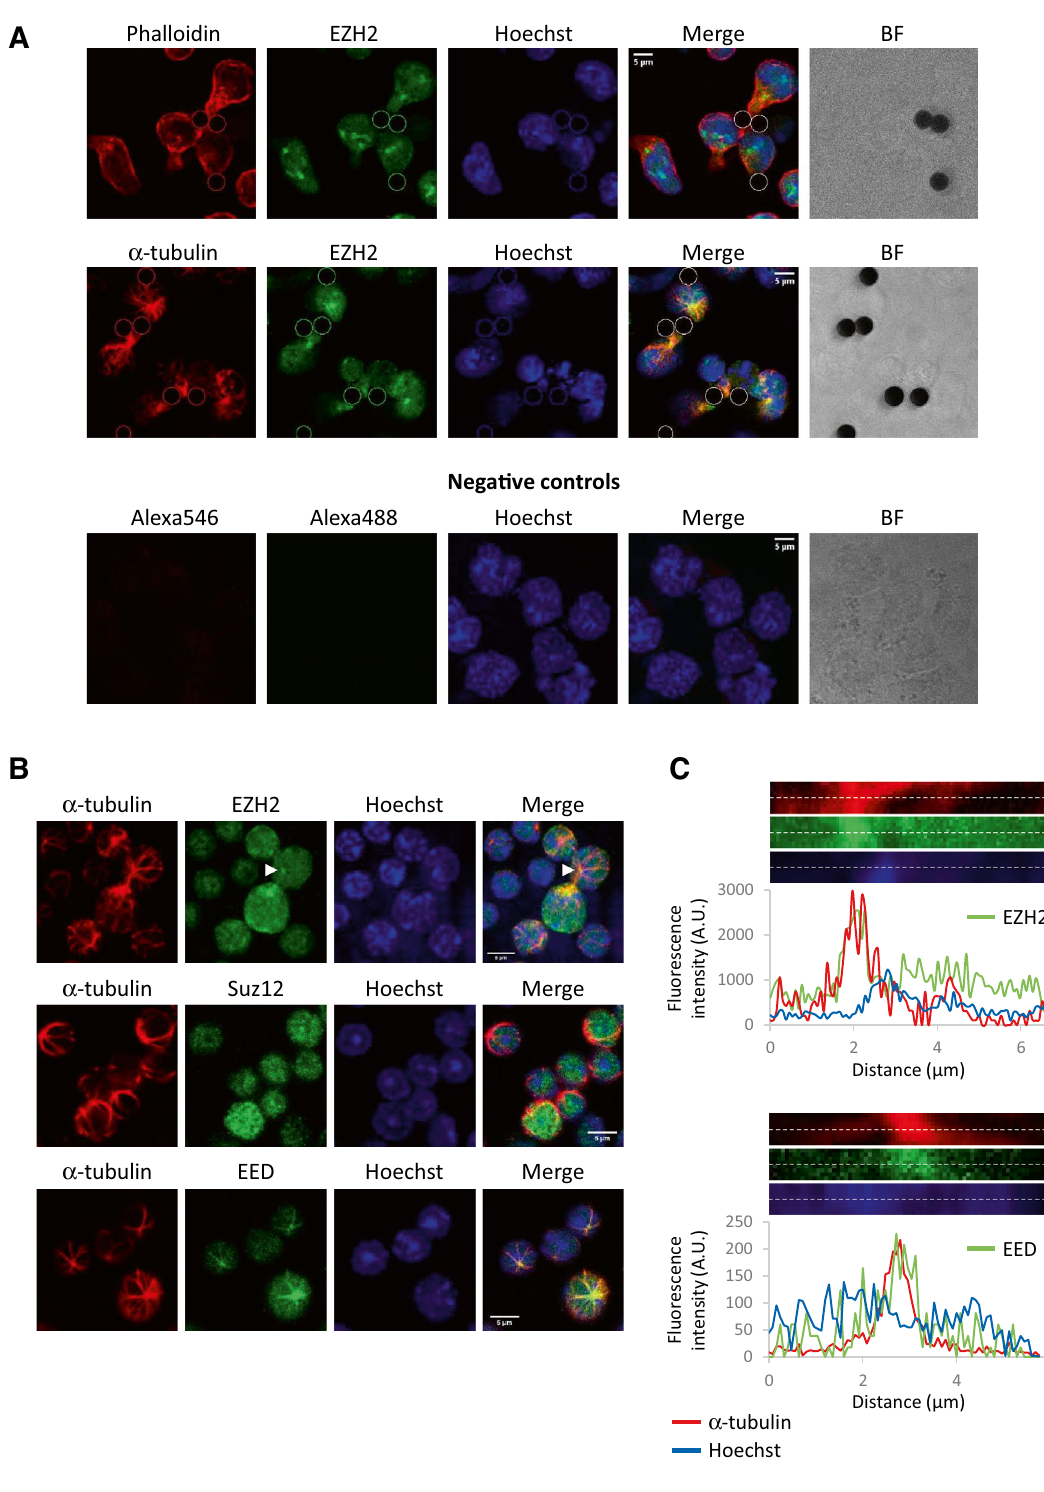
Figure 3. EZH2 and EED colocalize with α-tubulin. ( A ) The SCB29 cell line was stimulated with Dynabeads™ Mouse T-activator CD3/CD28 for 30 min. Localization of EZH2 (green) and F-actin (phalloidin, red) or α-tubulin (red) was analyzed. Bead localization was determined using brightfield (BF) and reported in each channel. Negative controls were performed using secondary antibodies. Scale bar 2 µm. ( B ) Costaining of EZH2, EED or Suz12 (green), α-tubulin (red) and Hoechst (blue) in murine thymocytes. The arrow indicates the cell analyzed in ( C ). Scale bar 5 µm. ( C ) Maximum fluorescence of EZH2 or EED and α-tubulin (corresponding to the centrosome) colocalize in thymocytes. For one representative cell, the histogram indicates the fluorescence intensity measured for EZH2 or EED, α-tubulin and the Hoechst channel in the center of the tubulin aster region. Dotted lines in pictures above histograms indicate analyzed